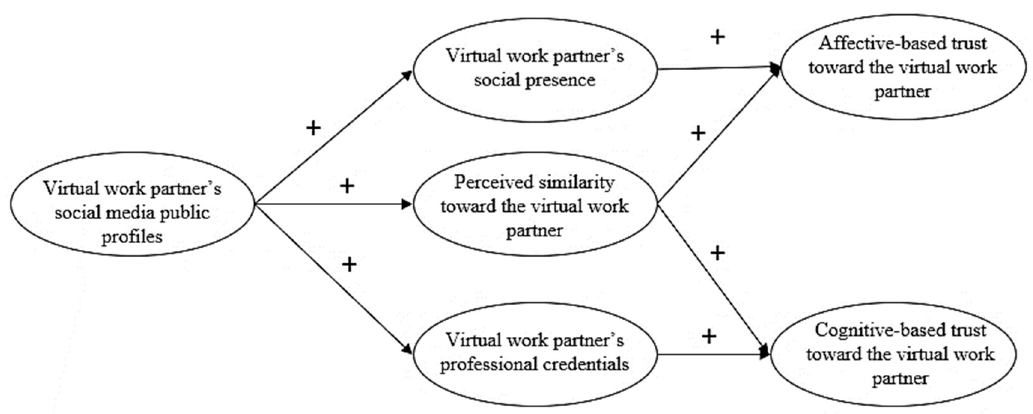
Figure 1. The theoretical model proposed.